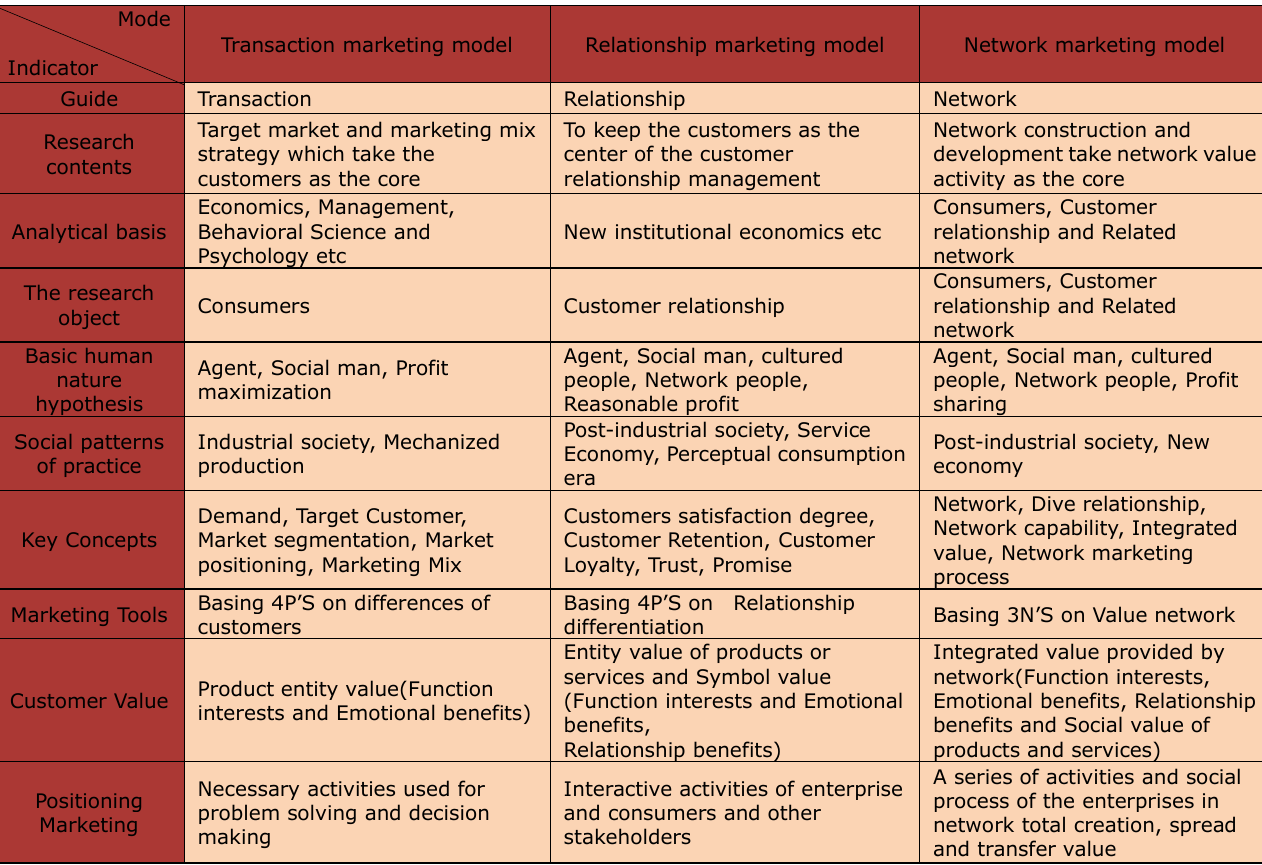
Table 3. Comparison of network marketing model with transaction marketing model and relationship marketing